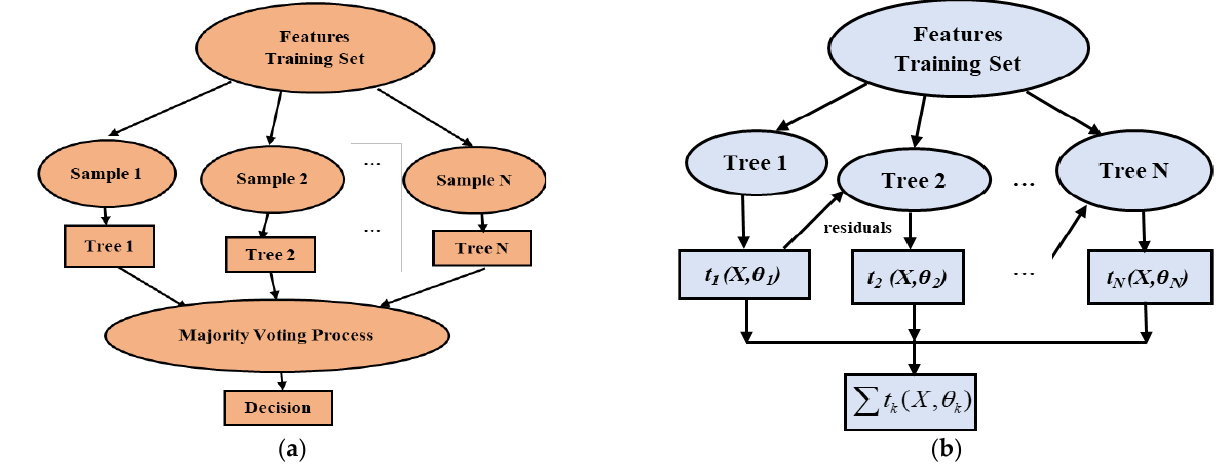
Figure 3. The basic architecture of ( a ) Random Forest and ( b ) Xtreme Gradient Boosting.